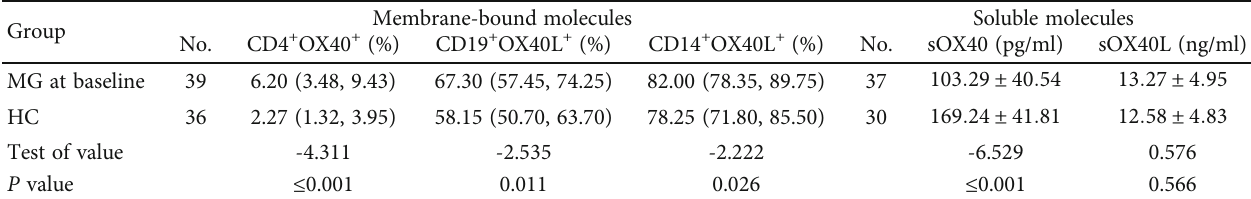
Table 2: OX40 and OX40L expression in patients with MG at baseline and healthy controls.